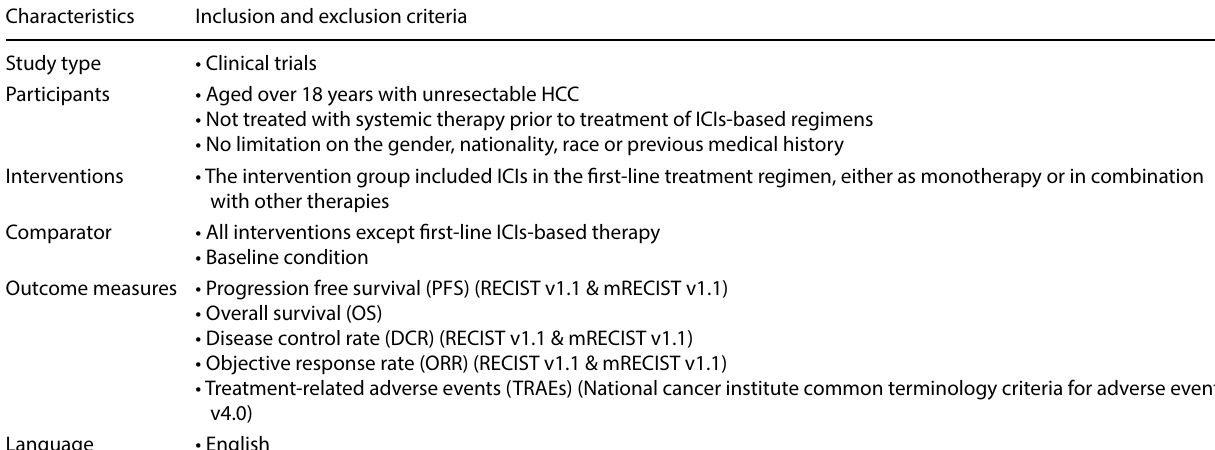
Table 1 Study inclusion and exclusion criteria Characteristics Inclusion and exclusion criteria Study